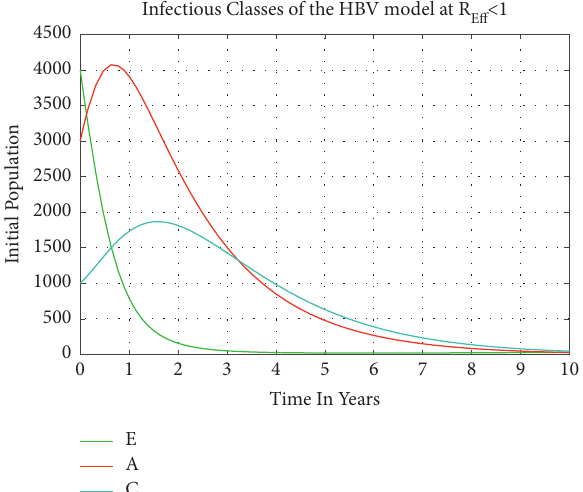
Figure 10: Behavior of infectious classes of SEACTR model when R < 1 . Eff